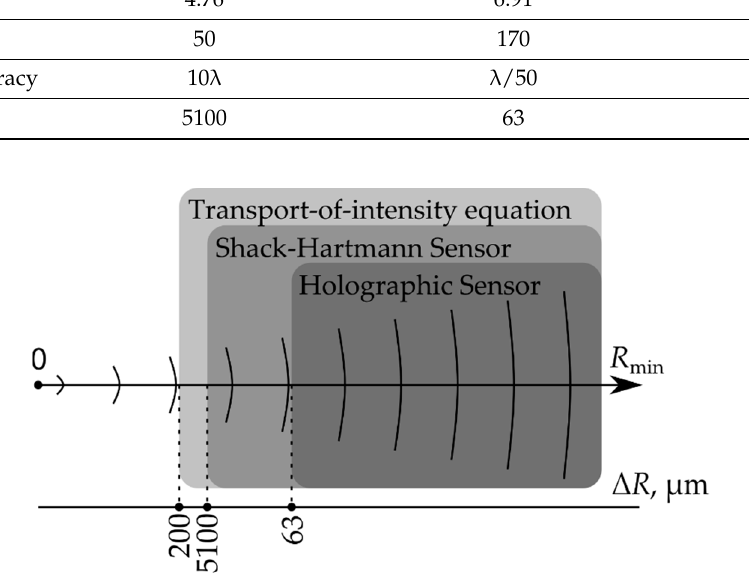
Figure 8. A visual comparison in the accuracy of determining the minimum RoC R min .